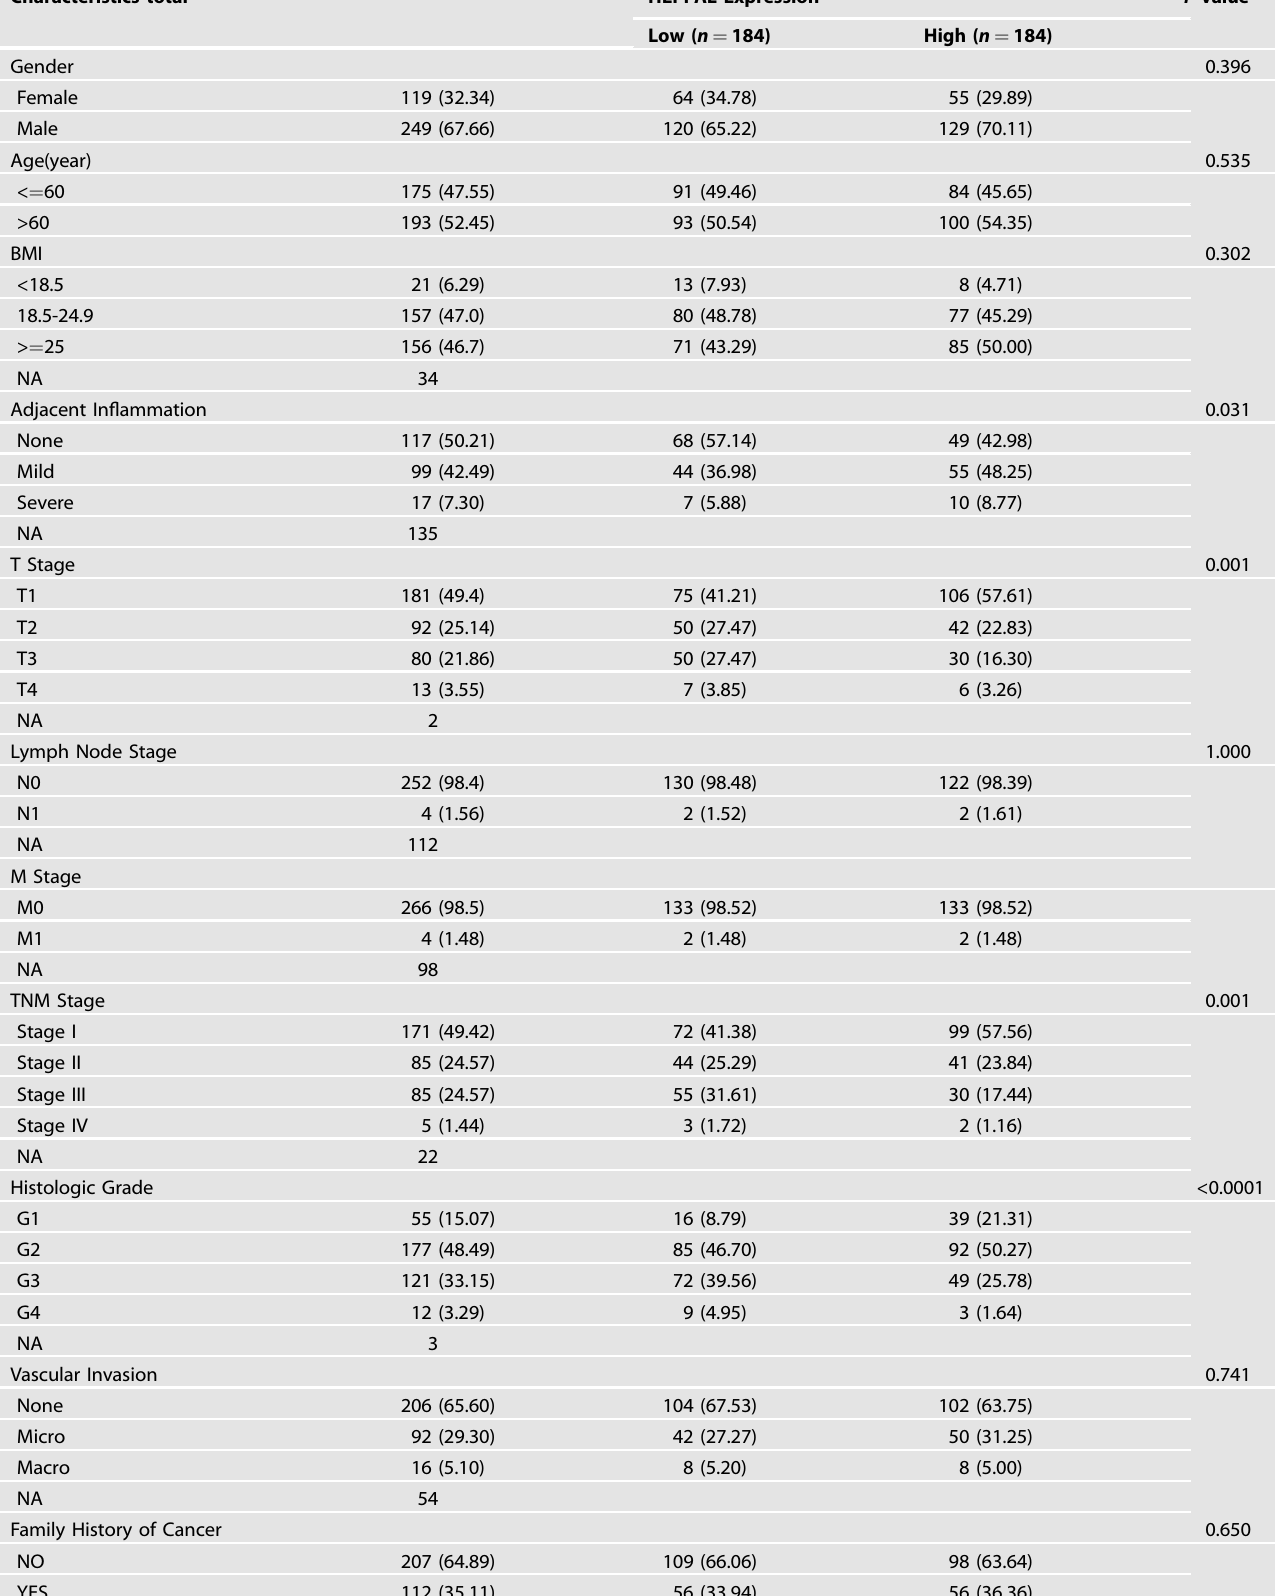
Table 1. Association of lncRNA HEPFAL expression and clinicopathological features of HCC patients in TCGA database ( n = 368). Characteristics